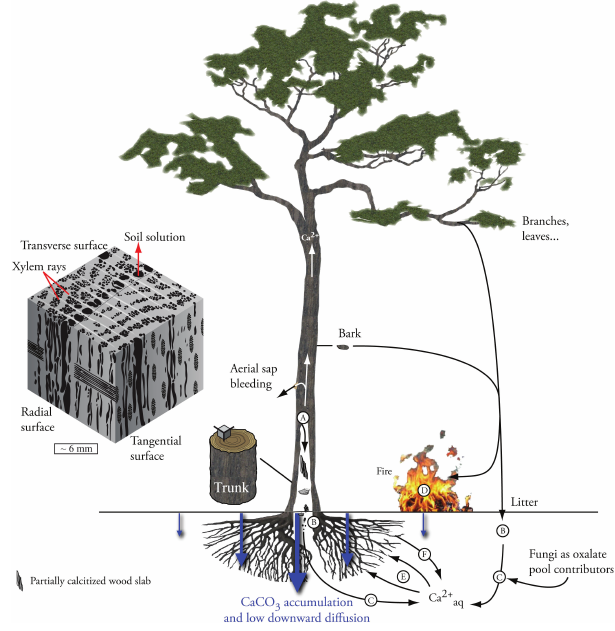
Fig. 5. Sketch showing the agents and the processes driving the iroko ecosystem. This sketch emphasizes the cycling of calcium, which is an important factor for oxalogenesis and carbonate pre- cipitation. (a) breakdown of wood mainly related to termites and fungi; (b) final wood decay leading to oxalate crystal release; (c) oxalate crystal oxidation by soil bacteria; (d) transformation of Ca- oxalate into Ca-carbonate during wood combustion; (e) soil solution pumped through roots; (f) root exudation. On the left handside of the sketch, a close-up of the wood structure is given to illustrate the different xylem